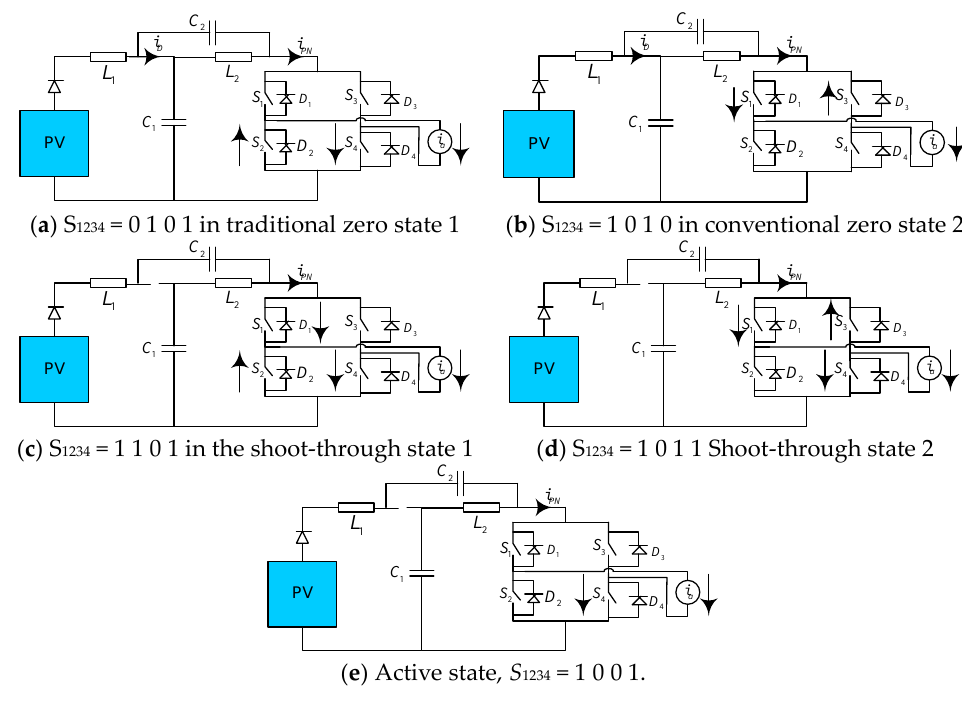
Figure 21. Equivalent circuits in one switching